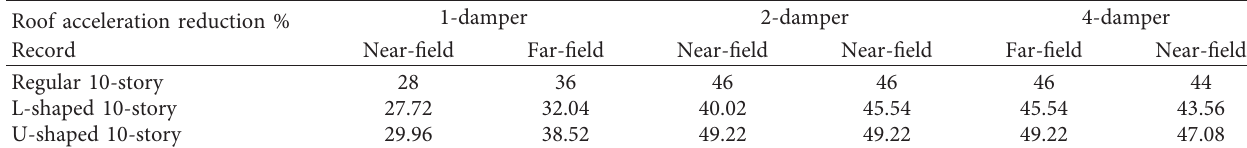
Table 9: Maximum acceleration reduction percentage in the regular and irregular 10-story models.